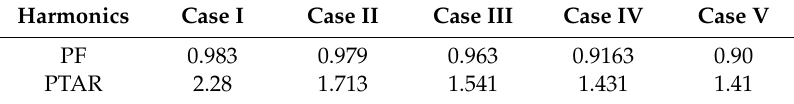
Figure 9. The input current waveform under different harmonics order combinations at 220 V in . Table 1. PTAR and PF values at different cases, V in = 220